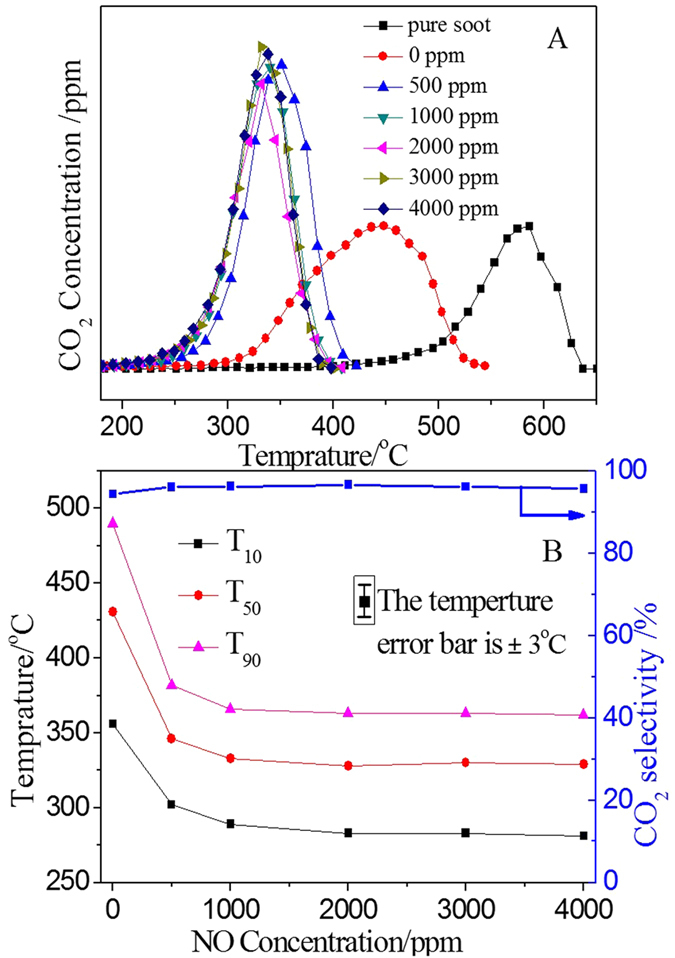
The CO2 concentration profiles (A) and catalytic activities (B) of K-OMS-2/SiO2-50 under different concentrations of NO (The temperature error bar is ±3 °C).